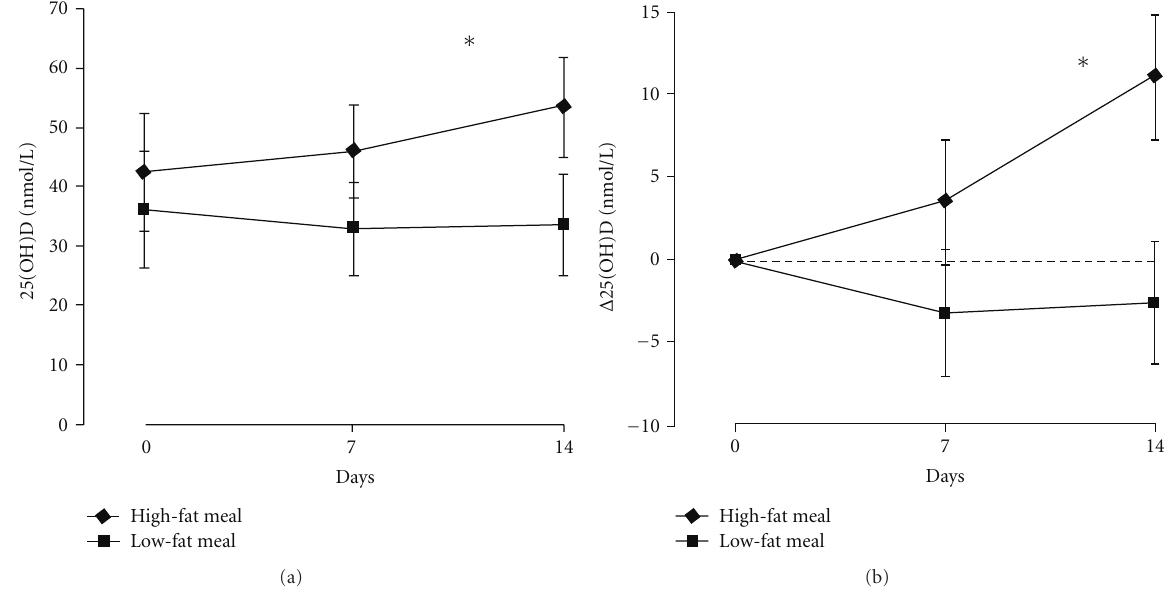
Figure 2: Mean serum 25(OH)D levels (a) and mean variation of serum 25(OH)D levels (b) were higher, after the intake of 50,000 IU of vitamin D 3 with a high-fat meal ( n = 15) when compared to a low-fat meal ( n = 15). ∗ P < 0 . 001, comparing the two slopes. Data are shown as mean and 95% confidence